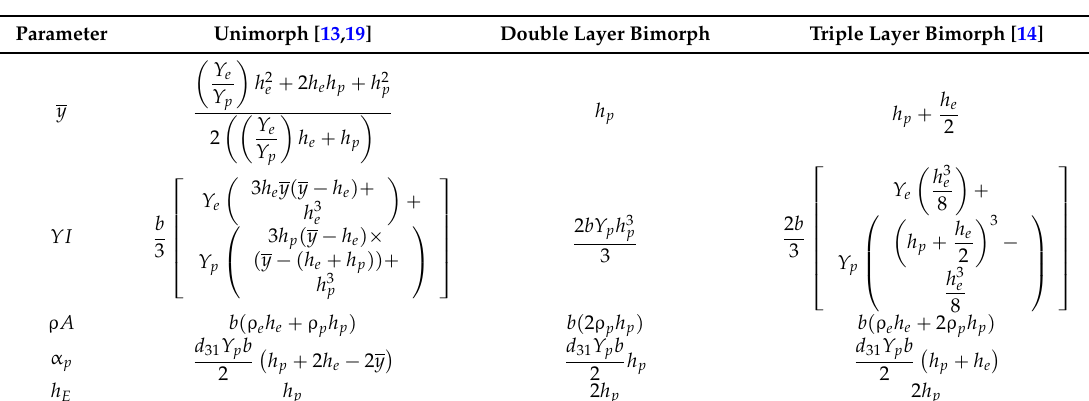
Table 1. Configuration parameters for different